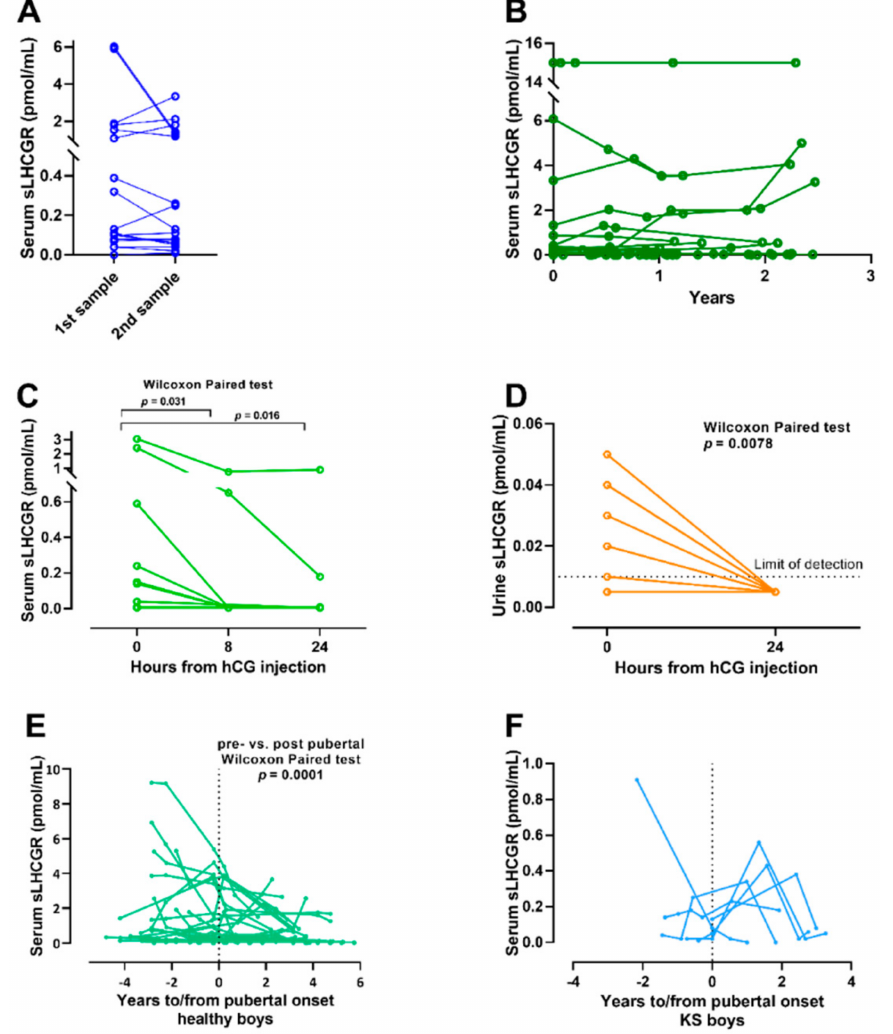
Figure 2. Longitudinal measurements of sLHCGR in serum and urine. ( A ): Repeated measurements of serum sLHCGR in adult Klinefelter men (timespan 4–36 months). ( B ): Repeated measurements of serum sLHCGR in 23 orchiectomized men. ( C ): Change in serum sLHCGR compared with baseline in 11 healthy men injected with 5000 IU hCG. ( D ): Change in urine sLHCGR in 11 healthy men injected with 5000 IU hCG. ( E ): Longitudinal measurements of sLHCGR in healthy boys during puberty. ( F ): Longitudinal measurements of sLHCGR in boys with Klinefelter syndrome (KS) during puberty. 3.5. Serum and Urine LHCGR Are Influenced by Treatment with Human Chorion Gonadotropin Injection of 5000 IU hCG (see Table 1 for baseline characteristics) lowered serum sLHCGR after 8 h (Wilcoxon Paired test p = 0.031) and the decrease was augmented after 24 h (Wilcoxon Paired Test p = 0.016, after Bonferroni correction, p < 0.025) (Figure 2C). Only two men had detectable sLHCGR in serum 24 h after injection those with the highest baseline values. The fast effect of hCG on circulating sLHCGR levels was also evident in the urine as the urinary sLHCGR levels fell to below the limit of detection in all the men after 24 h (Wilcoxon Paired Test p = 0.0078) (Figure 2D). Baseline serum sLHCGR, prior to hCG injection, was not correlated with baseline urine-sLHCGR, serum testosterone nor serum LH level, or with delta serum testosterone nor delta serum LH. Neither urinary sLHCGR was correlated with age nor reproductive hormones in serum. hCG induced an increase in serum testosterone, from 19.6 nmol/L (3.3 SD) to 28.2 nmol/L (4.4 SD) after 24 h (Wilcoxon Paired Test: p = 0.001) and to 43.9 nmol/L (8.6 SD) after 72 h ( p =